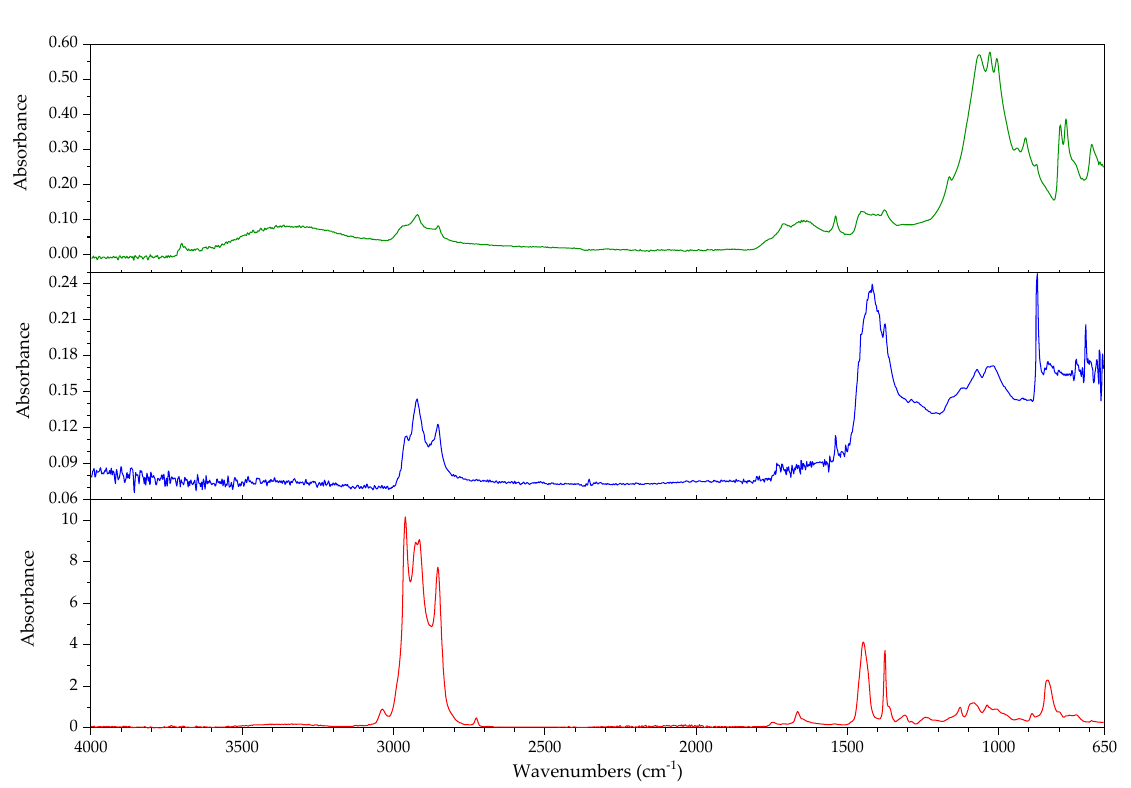
Figure 19. FTIR spectra of samples 194 (green line) and 431 (blue line) compared to reference spectrum of polyisoprene (red line) from a commercial database.